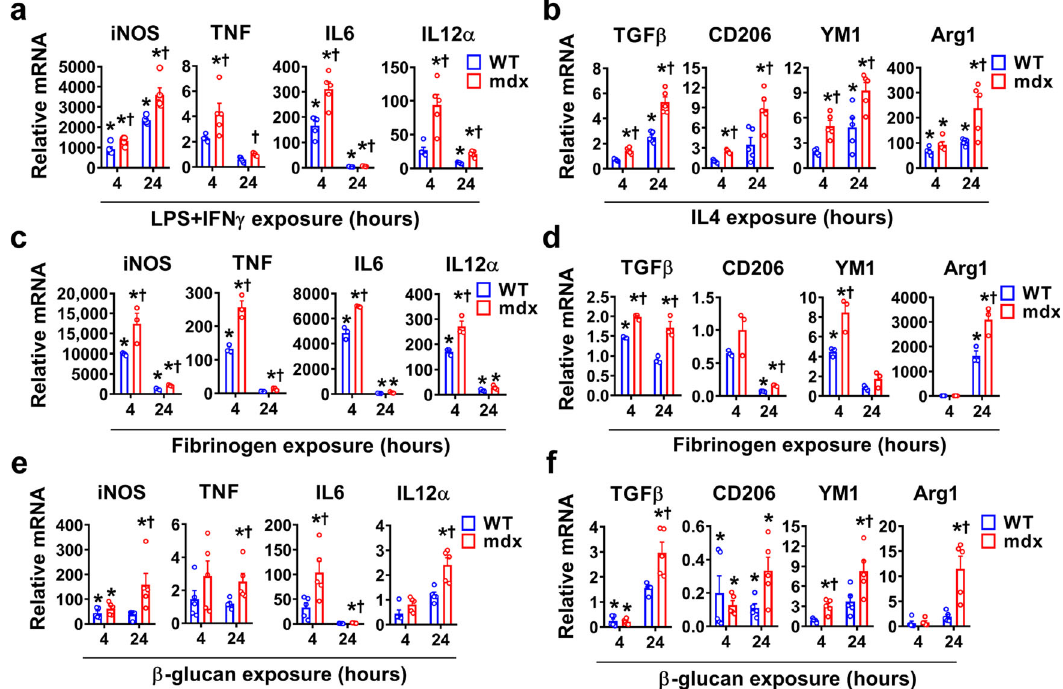
Fig. 3 mdx BMDM exhibit non-speci fi c ampli fi cation of M1 and M2 marker gene expression in response to heterologous stimuli. a – f BMDM from age- matched WT and mdx mice at the necrotic phase of disease were exposed to: a LPS + IFN γ ( n = 5/group), b IL4 ( n = 5/group), c , d fi brinogen ( n = 3/ group), or e , f β -glucan for 4 and 24 h ( n = 5/group); mRNA transcript data for prototypical M1 and M2 marker genes are expressed relative to the mean basal WT (unstimulated) level determined on the same PCR plate. Data represent means ± SEM of biologically independent samples from different mice. * P < 0.05 vs. unstimulated WT and † P < 0.05 vs. stimulated WT at a given time point (one-way ANOVA followed by Tukey post-hoc test, two-tailed). See Source Data fi le for the exact P